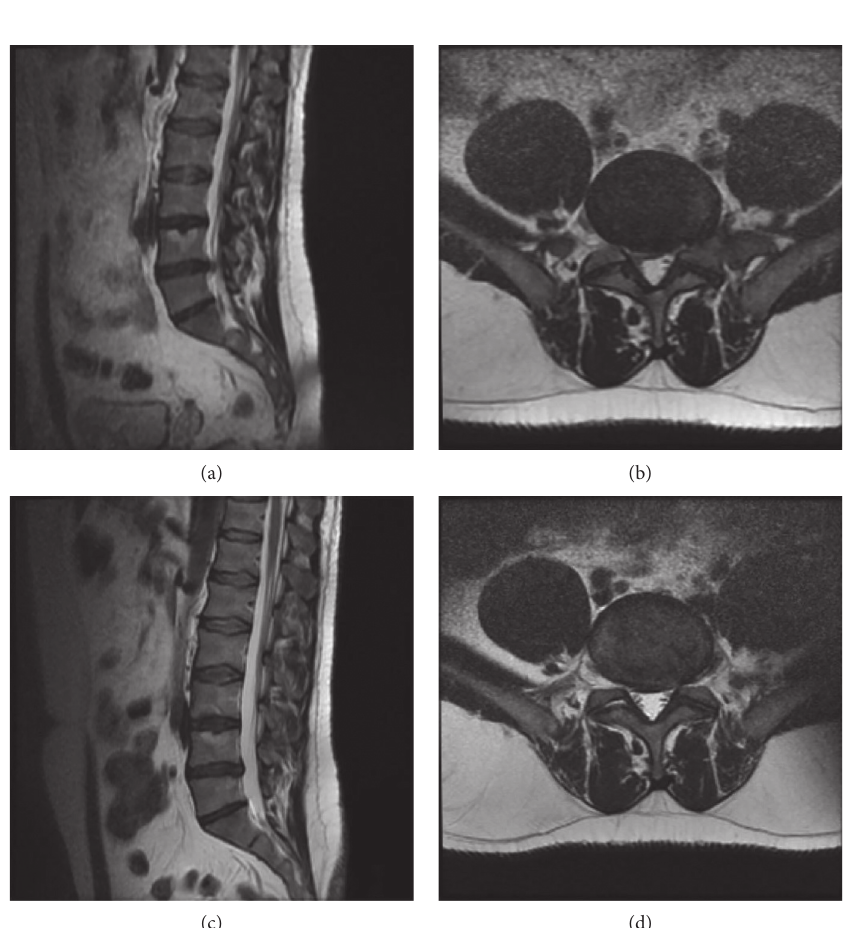
Figure 1: Preoperatively and postoperatively axial and sagittal images of MRI before/after Holmium-YAG laser-assisted ELND. (a) Preoperative sagittal MRI image of the patient. (b) Preoperative axial MRI image of the patient. (c) Postoperative sagittal MRI image of the patient. (d) Postoperative axial MRI image of the